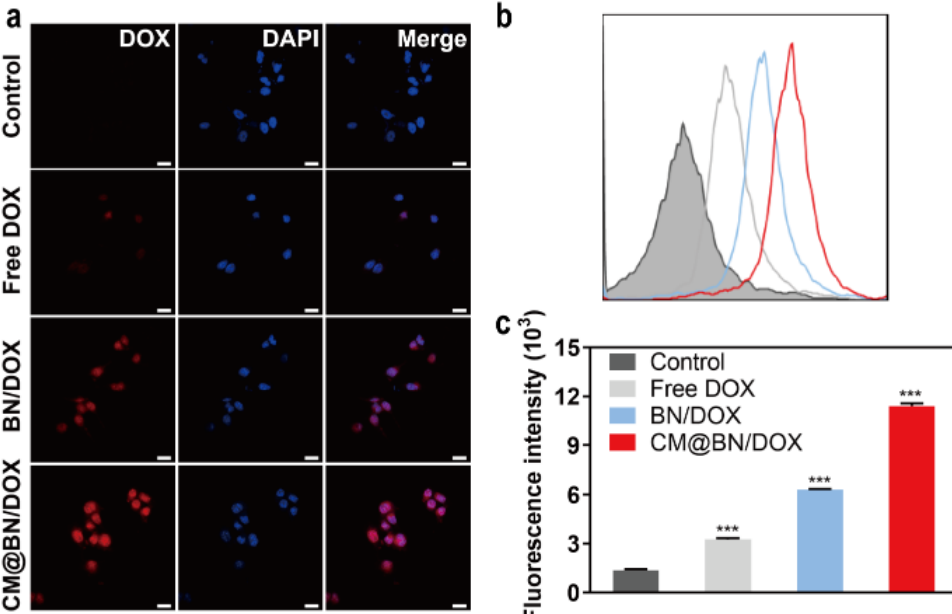
Figure 5. Cellular uptake. ( a ) Confocal laser scanning microscopy (CLSM) images of BV2 cells co- cultured with free DOX, BN@DOX, and CM@BN/DOX for 2 h. Scale bar = 20 µm. ( b ) Analysis of free DOX, BN/DOX, and CM@BN/DOX uptake by BV2 cells by flow cytometry (FCM). ( c ) Quantitative